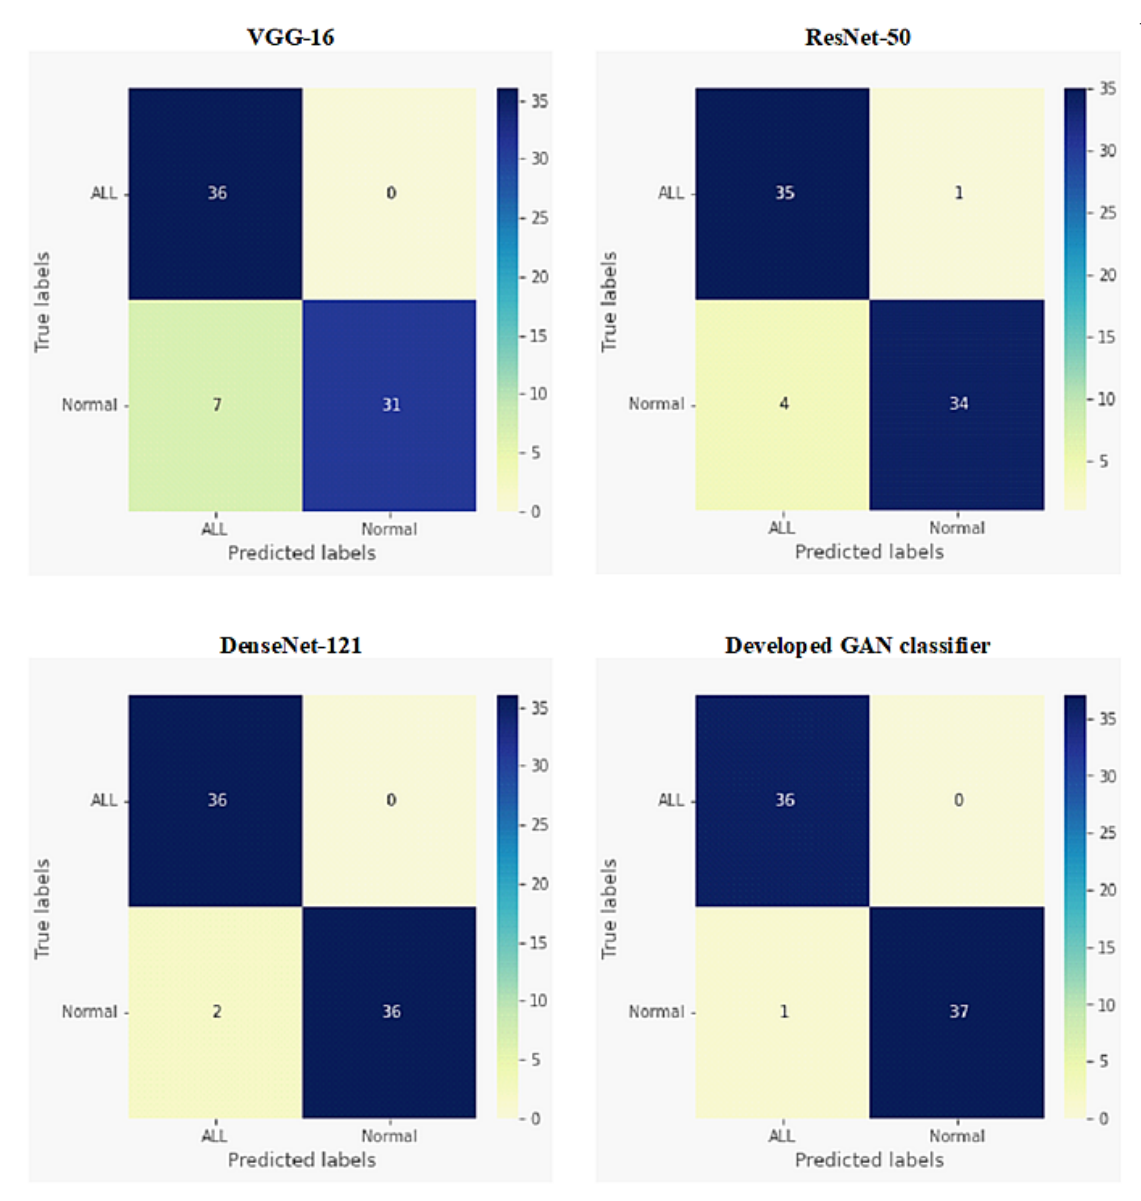
Figure 6. Confusion matrices for binary classification of ALL disease versus normal cases for all tested deep network